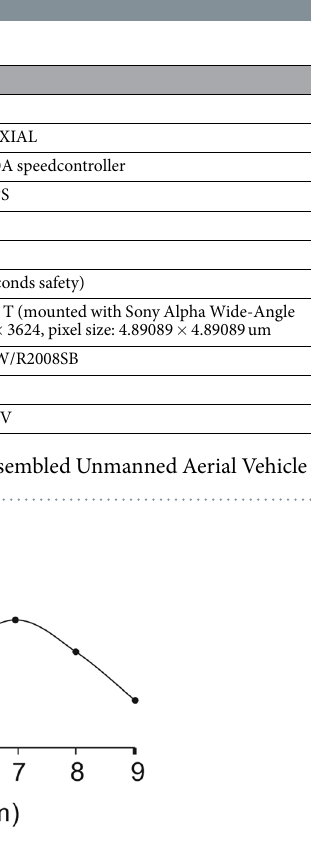
Figure 8. Number of matching markers to reconstruct the offsets from 2–9 m. The maximum markers correspond to an offset of ~7 m. We determined the uncertainty to be ± 1 m as we found almost the same number of matching markers for the offsets of 6 m and 8